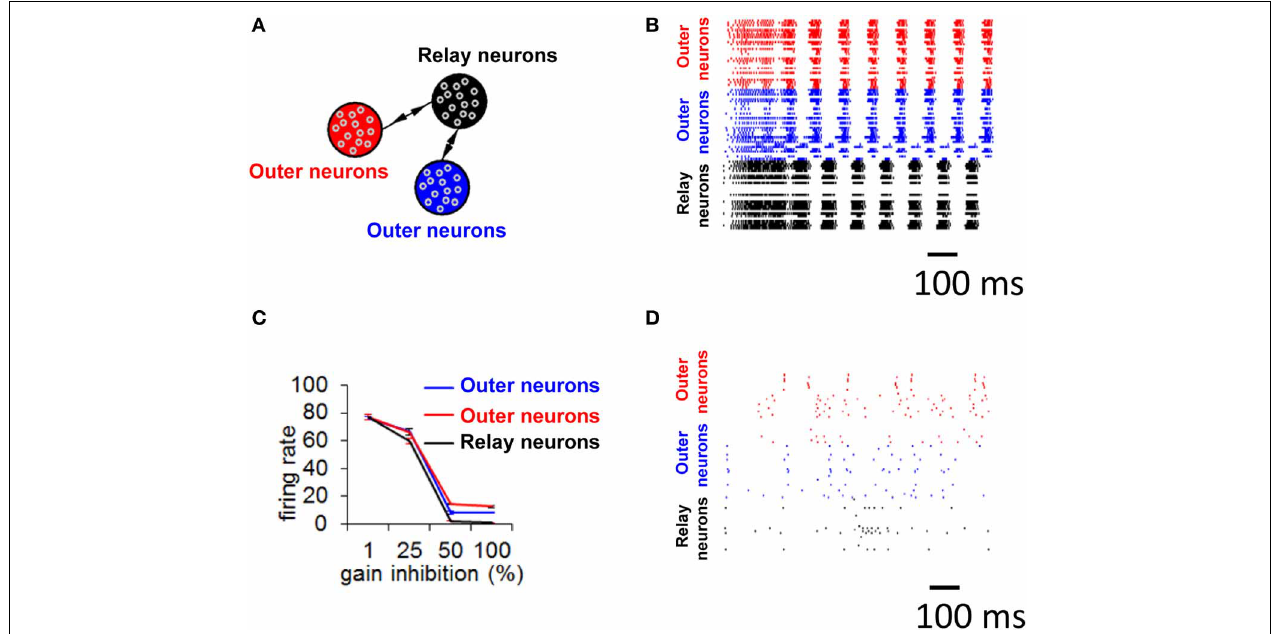
FIGURE 8 | Selective gain inhibition prevents limit cycle activity. (A) Relay network, with neurons divided into three subpopulations (shown in red, black, and blue, see Materials and Methods). Arrows indicate the presence of between-population connections. (B) Spike raster of spontaneous activity for 100 neurons from the relay network in (A) , with gain inhibition set to its default value ( g inh = 1 . 5nS). (C) Influence of gain inhibition on mean firing rates across a whole network. Each value of the graph is obtained from a